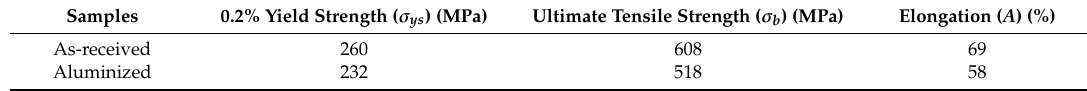
Table 3. Room-temperature mechanical properties of aluminized and as-received steel. Samples